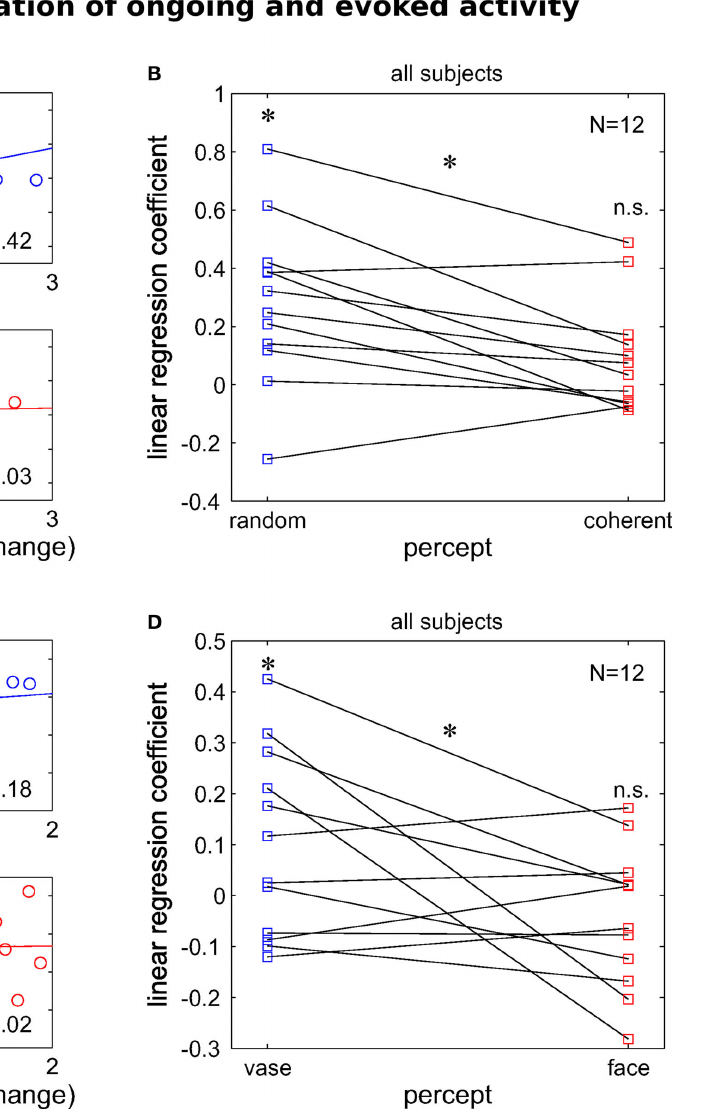
was perceived as random ( t = 1.7, n.s.) and significantly different between the 11 two perceptual outcomes ( t = 3.24, p < 0.01, paired). Adapted with permission 11 from Hesselmann et al. (2008a). (C,D) The face-vase decision experiment (cf. Figure 3B ): likewise, coefficients showed a trend >0 when faces were perceived ( t = 1.88, p = 0.087) but not when the vase was perceived 11 ( t = –1.06, n.s.). Importantly, they were significantly different between the two 11 perceptual outcomes ( t = 2.31, p < 0.05, paired). Dataset from Hesselmann et 11 al. (2008b). All tests are two-sided t = 3.55, p < 0.01) but not when it 11